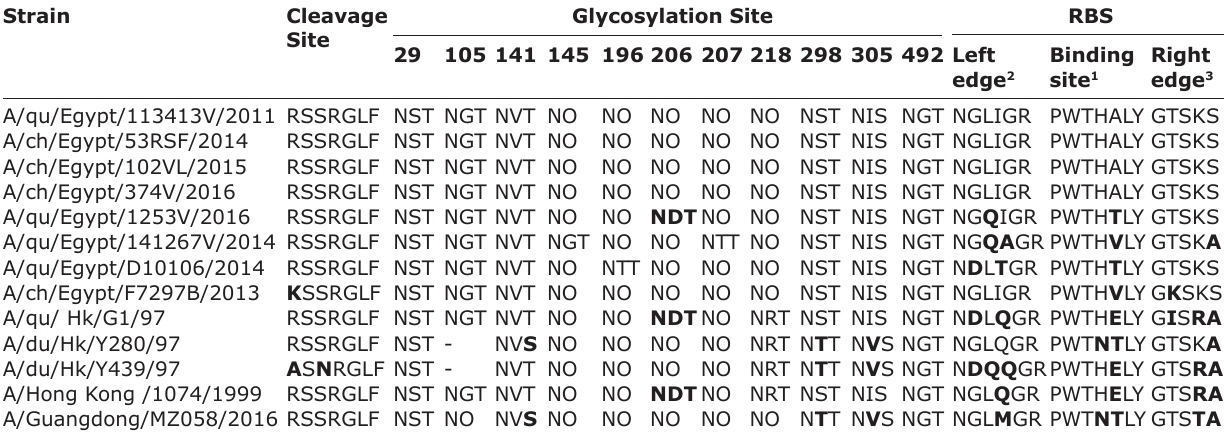
Table-2: Comparison of amino acid sequences of HA protein of H9N2 viruses in Egypt . Strain Cleavage Site